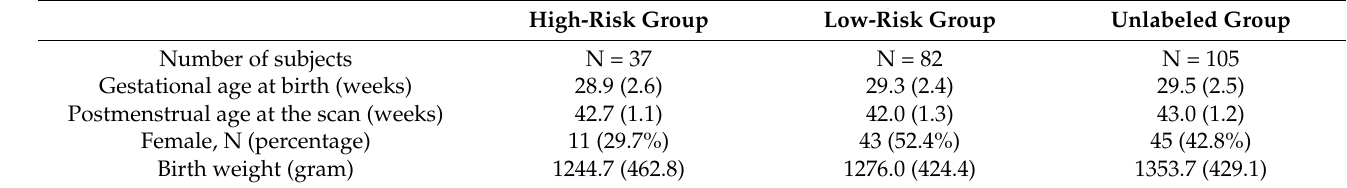
Table 1. Demographics of the subjects in the high-risk group, the low-risk group, and the unlabeled group. High-Risk Group Low-Risk